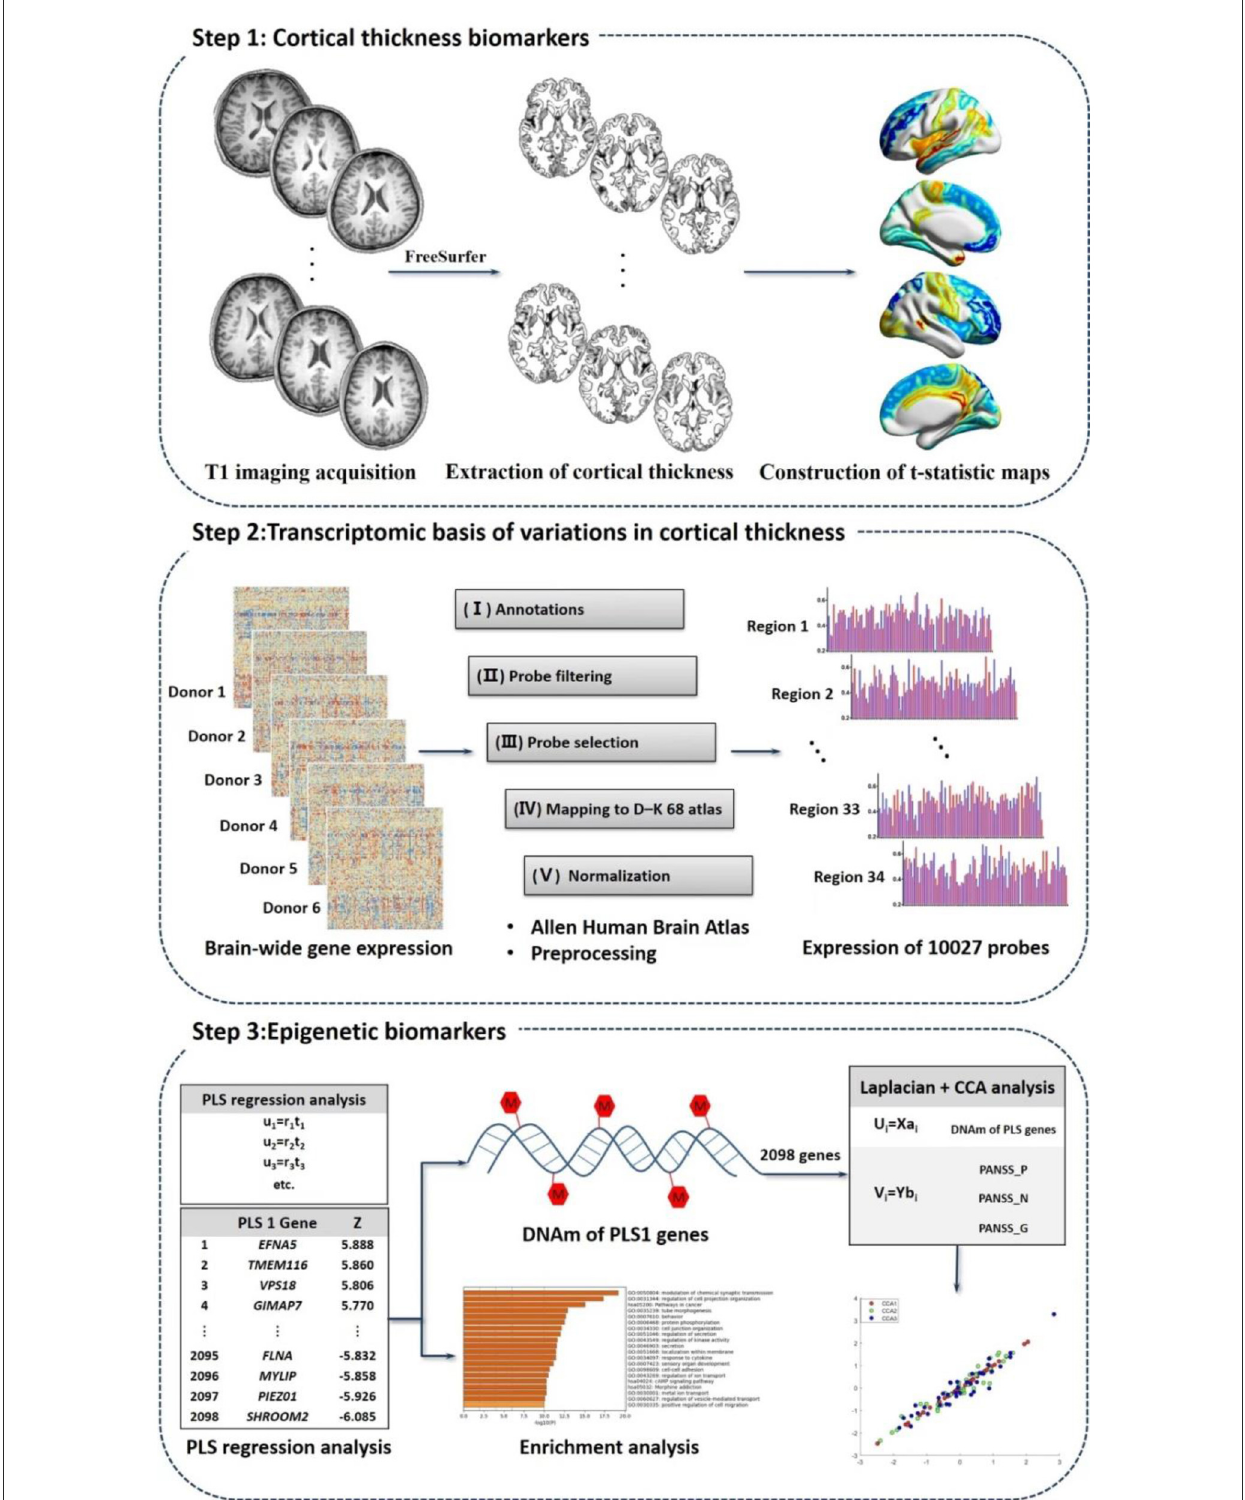
FIGURE1 Study overview of imaging-transcriptomics-epigenetics analysis.